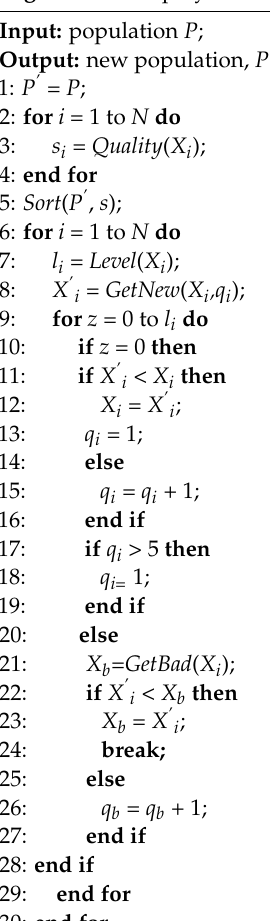
Algorithm 3 Employed bee